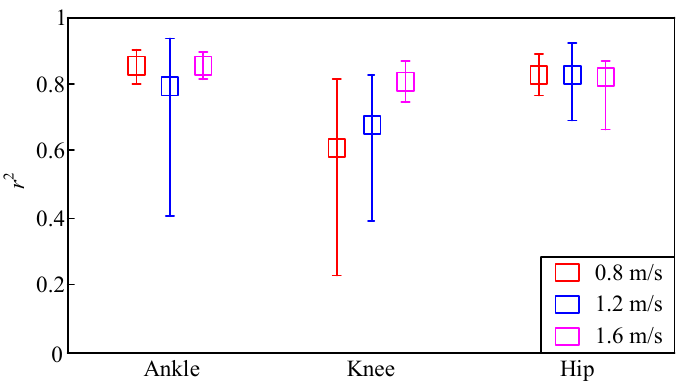
Figure 8. Mean, maximal, and minimal values of r 2 for untrained speed levels.